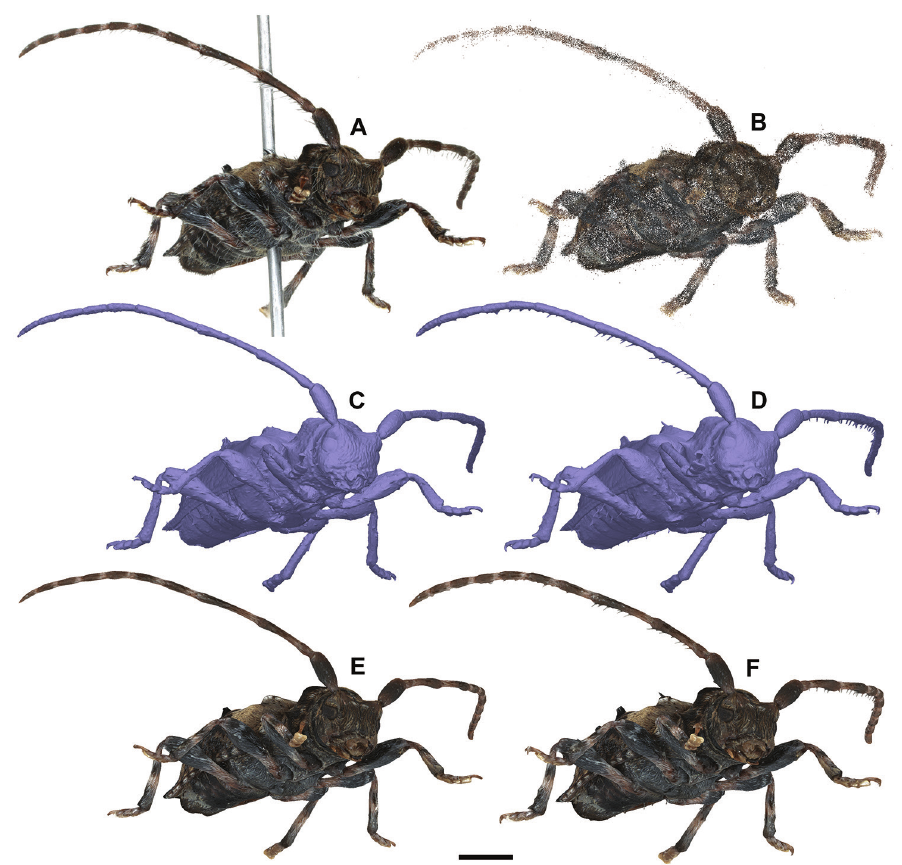
Figure 9. Workflow of model generation of Pogonocherus hispidus with PhotoScan Pro. In total, 398 EDOF-images are taken with DISC3D (one example is shown in A ). Using the image data, masks and camera positions estimated with the calibration sphere (see Fig. 6), a sparse cloud with optimized camera positions is generated ( B ). Two options for model generation are available: direct mesh calculation based on a dense point cloud ( C ) or meshing with visual consistency ( D ). Resulting meshes can be textured ( E, F ). Scale bar: